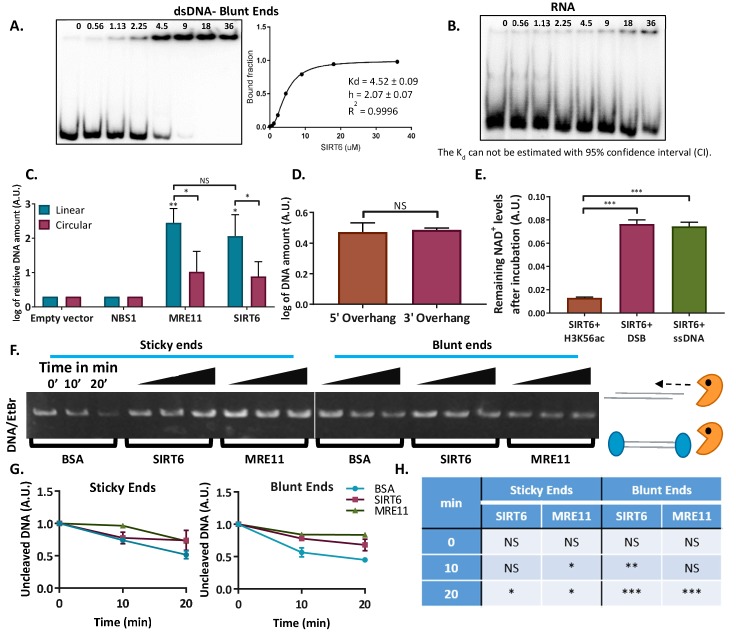
SIRT6 binds DNA with no intermediates.(A) Gel retardation assay of 32 P-5′ end-labeled dsDNAs with blunt ends as a function of increasing concentrations of SIRT6-His. (B) Gel retardation assay of 32 P-5′ end-labeled RNAs as a function of increasing concentrations of SIRT6-His. Kd could not have been calculated with a 95% confidence interval (CI). (C) DNA-binding ability of SIRT6-Flag, MRE11-Flag and NBS1-Flag for circular and linear plasmids, assessed by a DNA-binding assay. Data are means for 3–9 experiments (with error bars representing SEMs) after logarithmic transformation. (D) SIRT6-Flag DNA-binding ability for plasmids with a 3′ over-hang and a 5′ over-hang assessed by a DNA-binding assay. Log of averages of three experiments (with error bars representing SEMs). (E) Relative amount of NAD+ remaining after consumption by SIRT6 in the presence of DNA alone or with an acetylated peptide (H3K56ac). (F, G) Protection of sticky-ended and blunt-ended plasmids by BSA, SIRT6 and MRE11 against Exonuclease 1 in different time points. Data in panel (G) are means (with error bars showing +/- SEM) from three experiments. (H) Statistical analysis of the end protection: amounts of uncleaved DNA remaining in the presence of SIRT6 or MRE11 compared to BSA (as a control) after 0, 10 or 20 min (*, p <0.05; **, p <0.005; ***, p <0.0005).